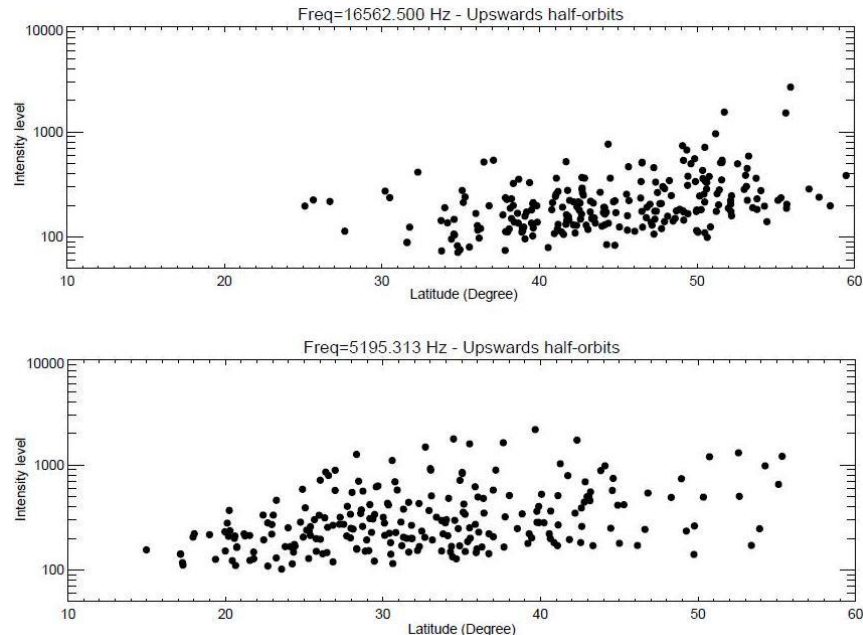
Fig. 5. Variation of the averaged intensity level versus the DEMETER satellite latitudes in the case of the transmitter signal ( f =16562.5Hz) and the VLF whistler emissions ( f =5195.313). The intensity measurement points are similar to those shown in Fig.